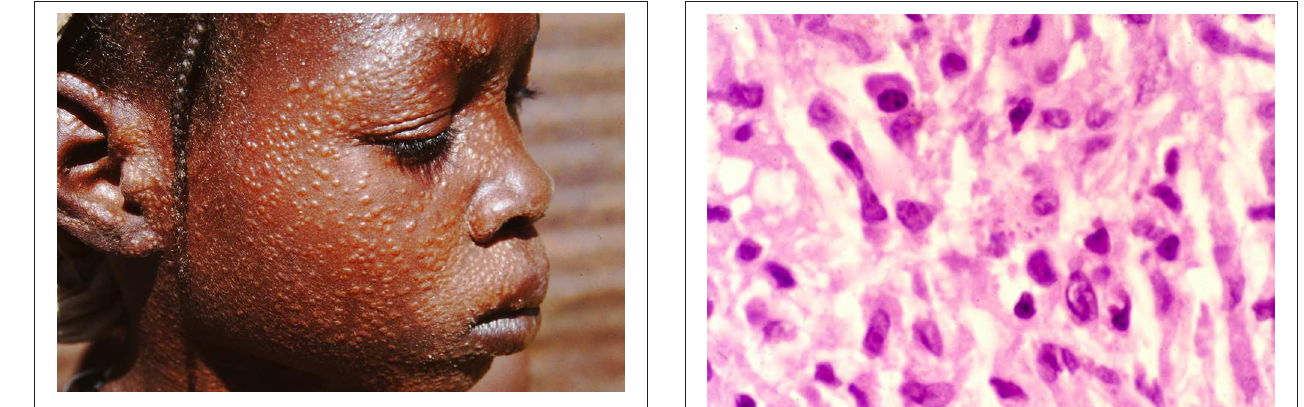
FIGURE 3 | Parasites can be seen in a skin biopsy taken from a PKDL